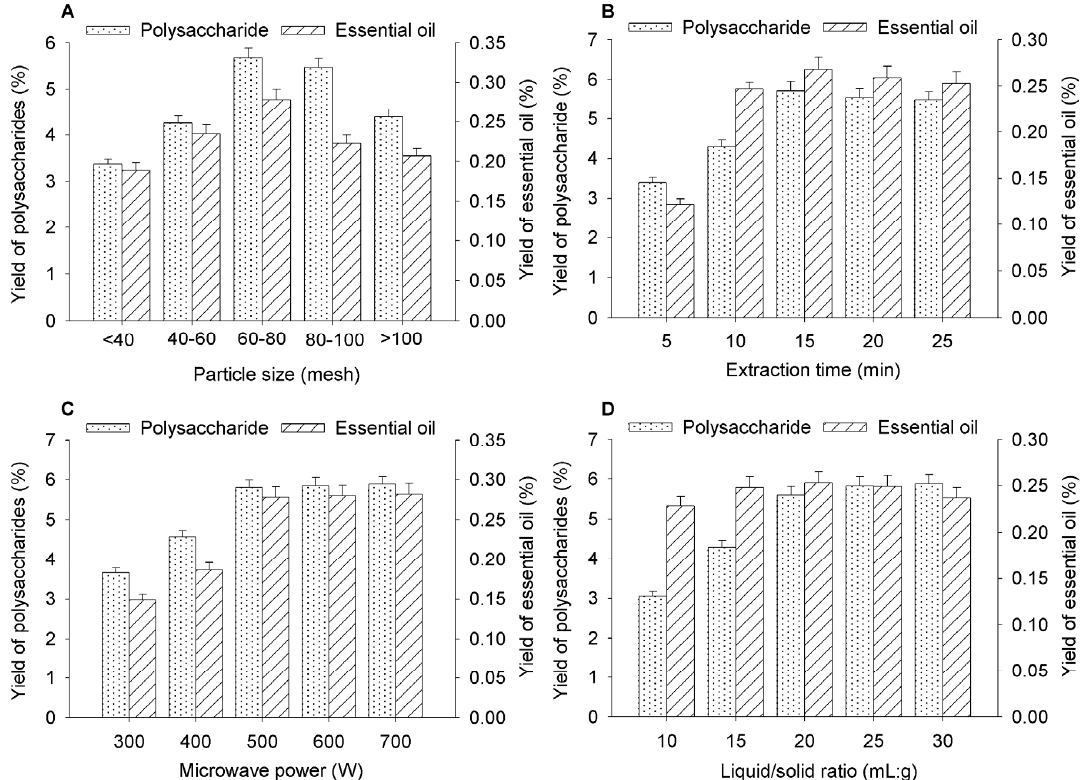
Figure 3. Effects of the different factors on the yields of the polysaccharides and essential oil from T. chinensis var. mairei . ( A ) effect of particle size of sample; ( B ) effect of extraction time; ( C ) effect of the microwave power; ( D ) effect of liquid/solid ratio. The error bars represent the standard deviation ( n = 3).